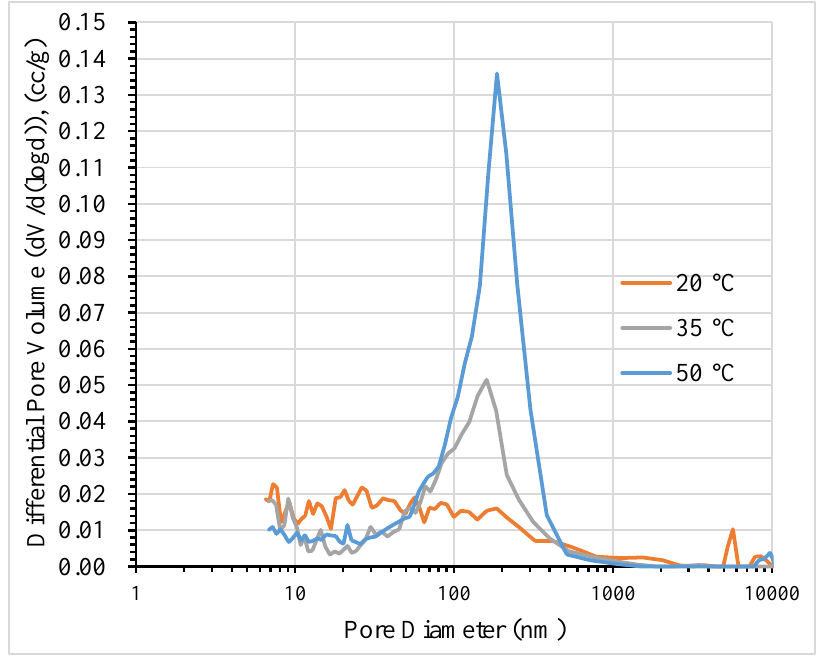
Figure 3. The differential pore size distribution of mortar at 60% RH. Figure 3. The di ff erential pore size distribution of mortar at 60%